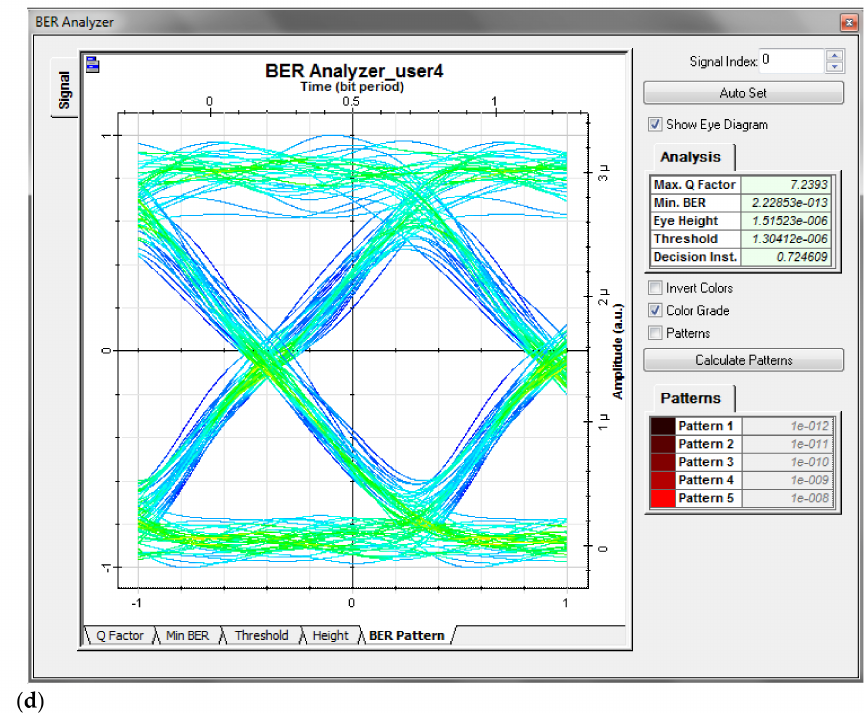
Figure 7. Received electrical eye diagrams: ( a ) for user 1; ( b ) for user 2; ( c ) for user 3; ( d ) for user 4. The bit rate is 5 Gb/s per user and the transmission is over 50 km of SMF.